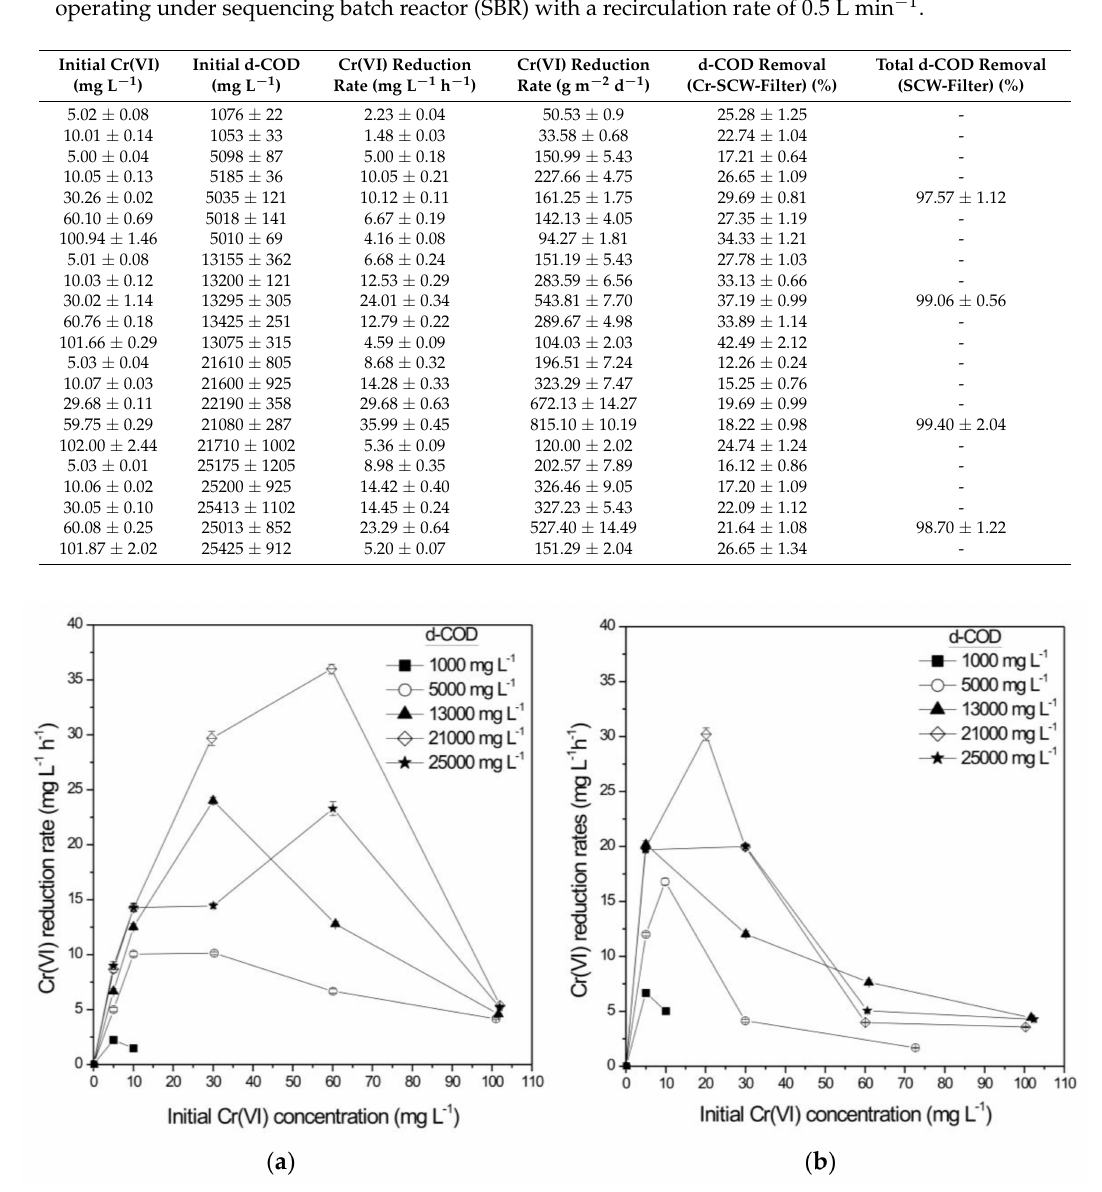
Figure 2. Cr(VI) reduction rates in the Cr-SCW-filter operating under SBR with recirculation mode for various initial Cr(VI) and d-COD concentrations and two different recirculation rates: ( a ) 0.5 L min − 1 and ( b ) 1.0 L min − 1